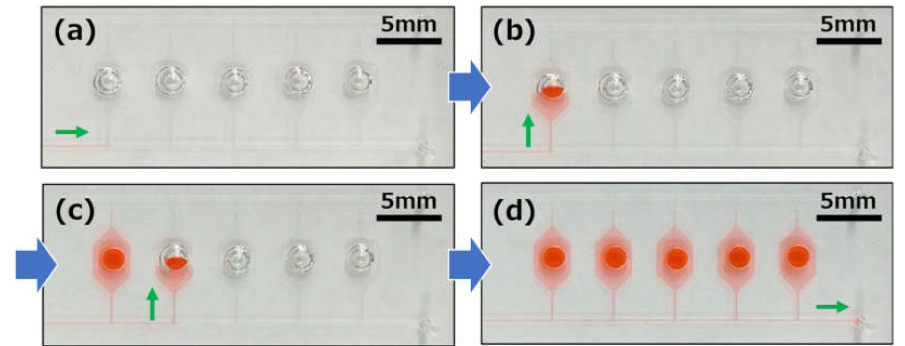
Figure 13. Experimental results showing the performance of autonomous sample dispensing into each reaction chamber using three types of phaseguide structures with di ff erent inclined angles against the flow direction. ( a ) The flow of water was stopped after reaching the phaseguide P 1 . ( b ) The flow direction was changed toward the first microchamber by passing through the phaseguide P 2 . ( c ) The flow toward the second microchamber occurred by passing through the phaseguide P 1 . ( d ) All of the microchambers were autonomously filled with water sequentially by repeating this